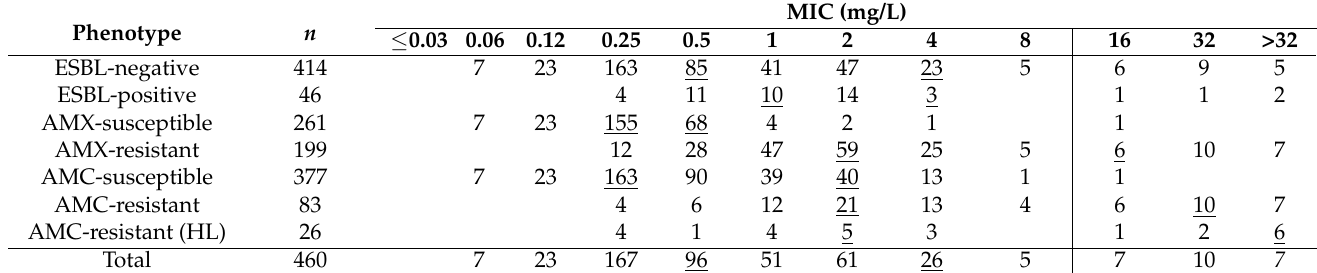
Table 2. MIC distribution data for mecillinam against 460 E. coli urine isolates with different resistance